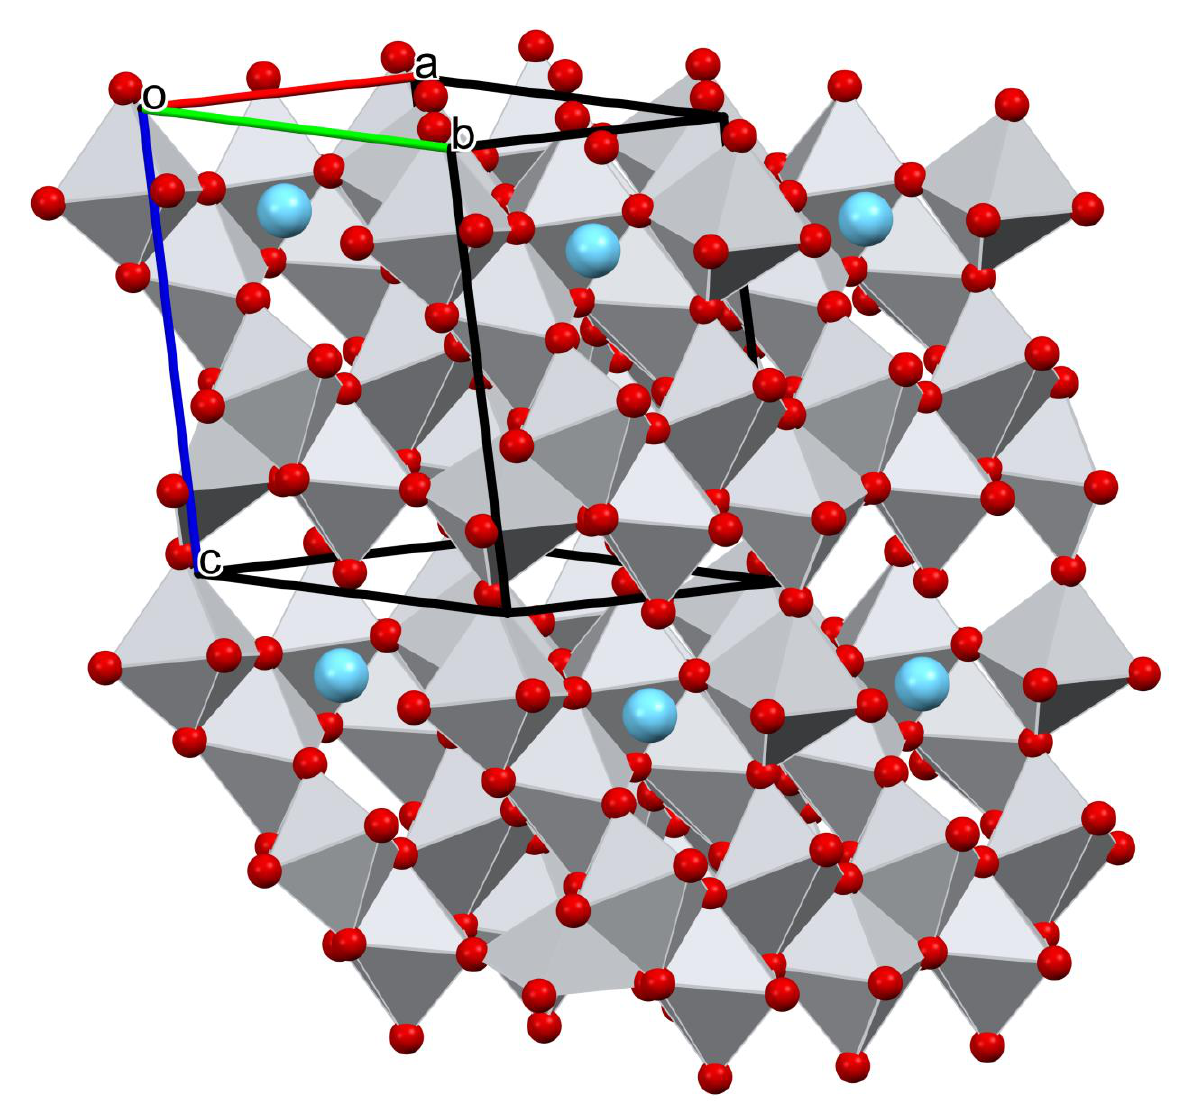
Figure 8. Polyhedral representation of the structure La 0.987 Ti 1.627 Nb 3.307 O 13 . The octahedra have oxy-